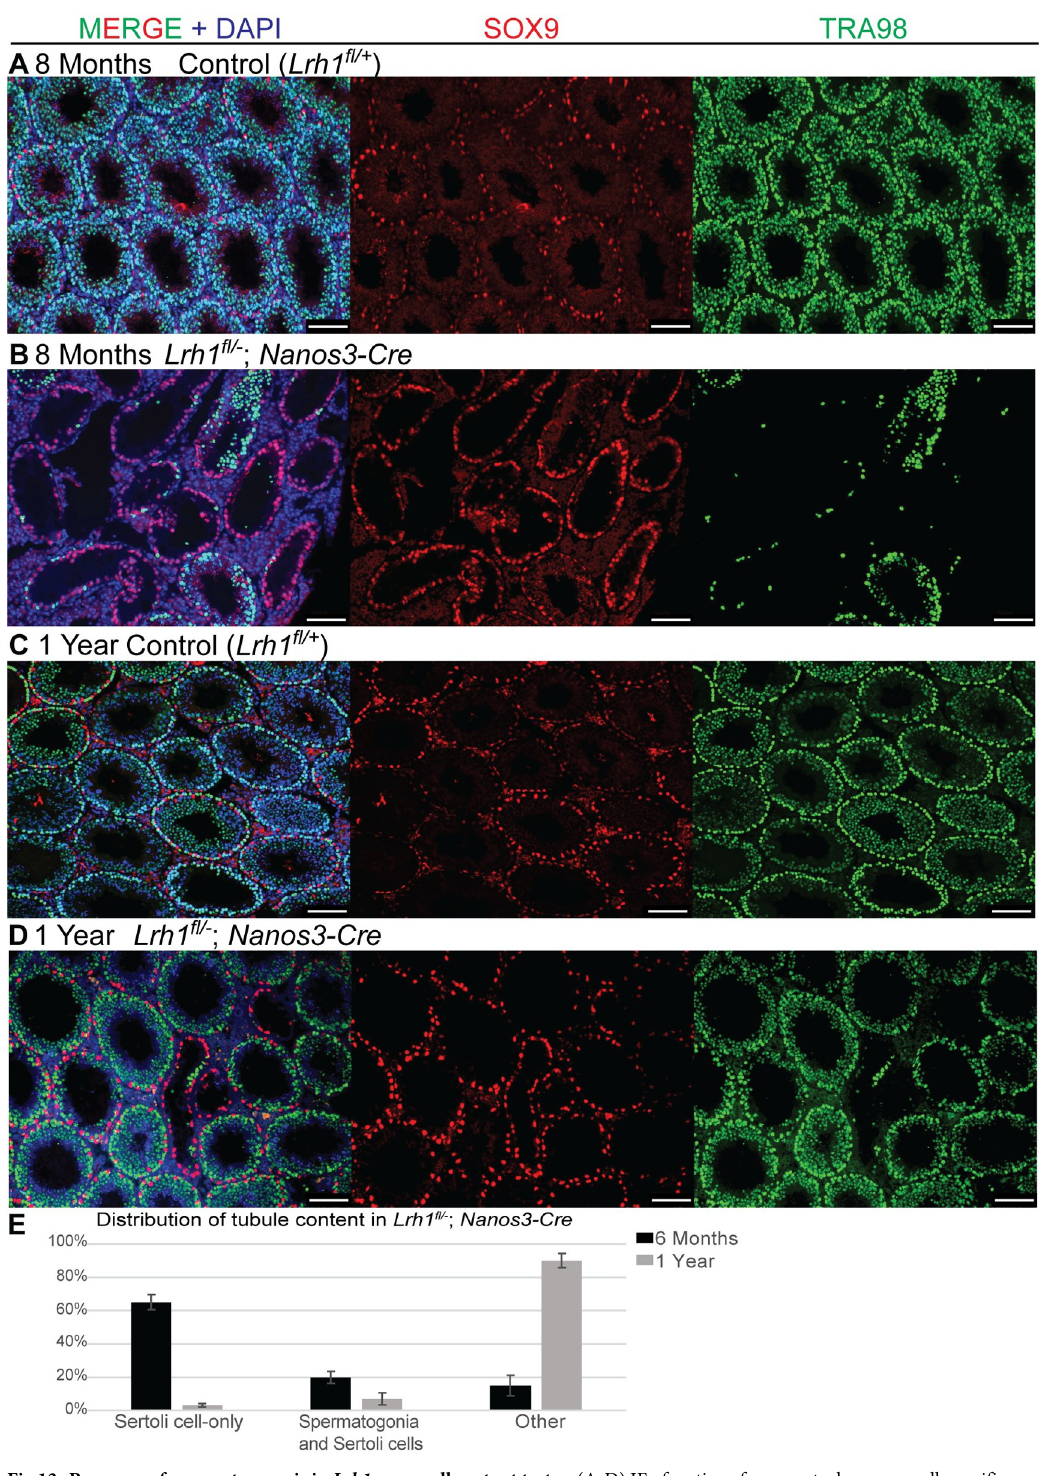
Fig 13. Recovery of spermatogenesis in Lrh1 germ cell mutant testes. (A-D) IF of sections from control or germ cell-specific Nanos3-Cre Lrh1 mutant testes stained for SOX9 (red), TRA98 (green) and DAPI (blue) at eight months (A,B) and one year (C,D). Scale bars: 100 um. (E) Plot of germ cell composition of seminiferous tubules in germ cell mutant testes at six months and one year. Error bars: